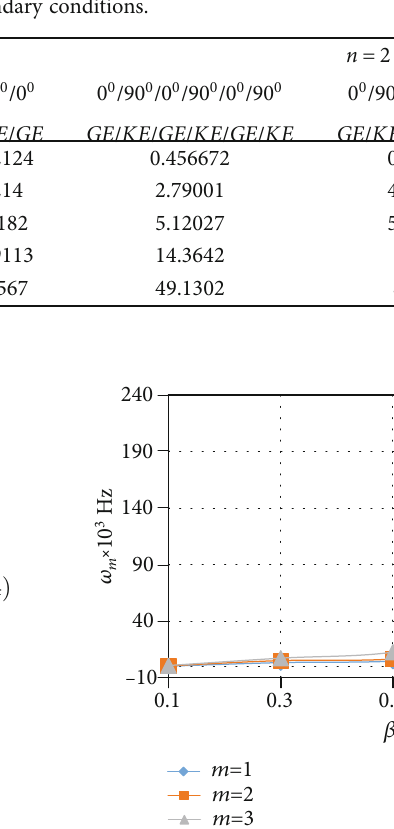
Table 1: Comparison of natural frequency parameter (rad/s) of the present study λ = ω ℓ and Liu et al. [55] of simply supported annular circular plates β = 1/6, γ = 1/60 . Circumferential node number